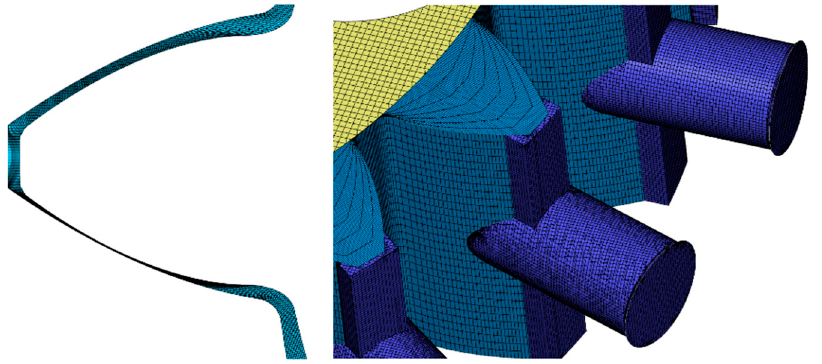
Figure 4. Details of the mesh in the minimum volume and in the radial holes.